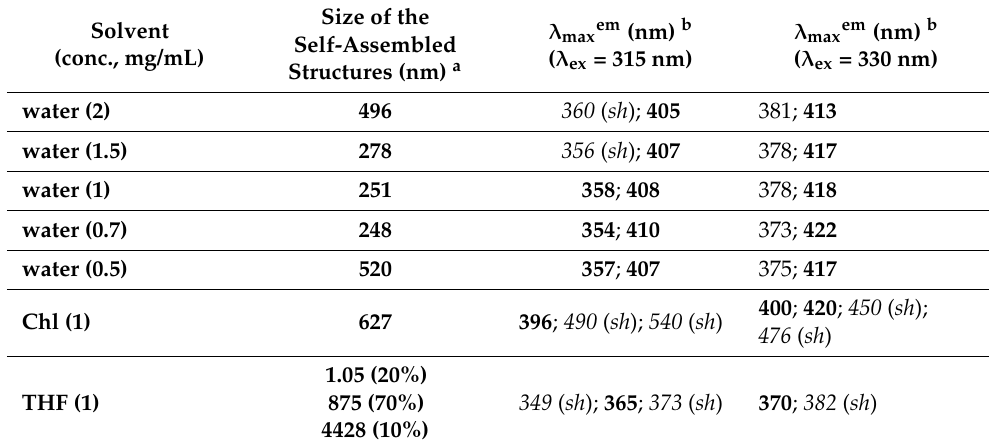
Table 1. Size of self-assembled structures formed by Th-OMeOx in different solvents at various concentrations and their fluorescence data c